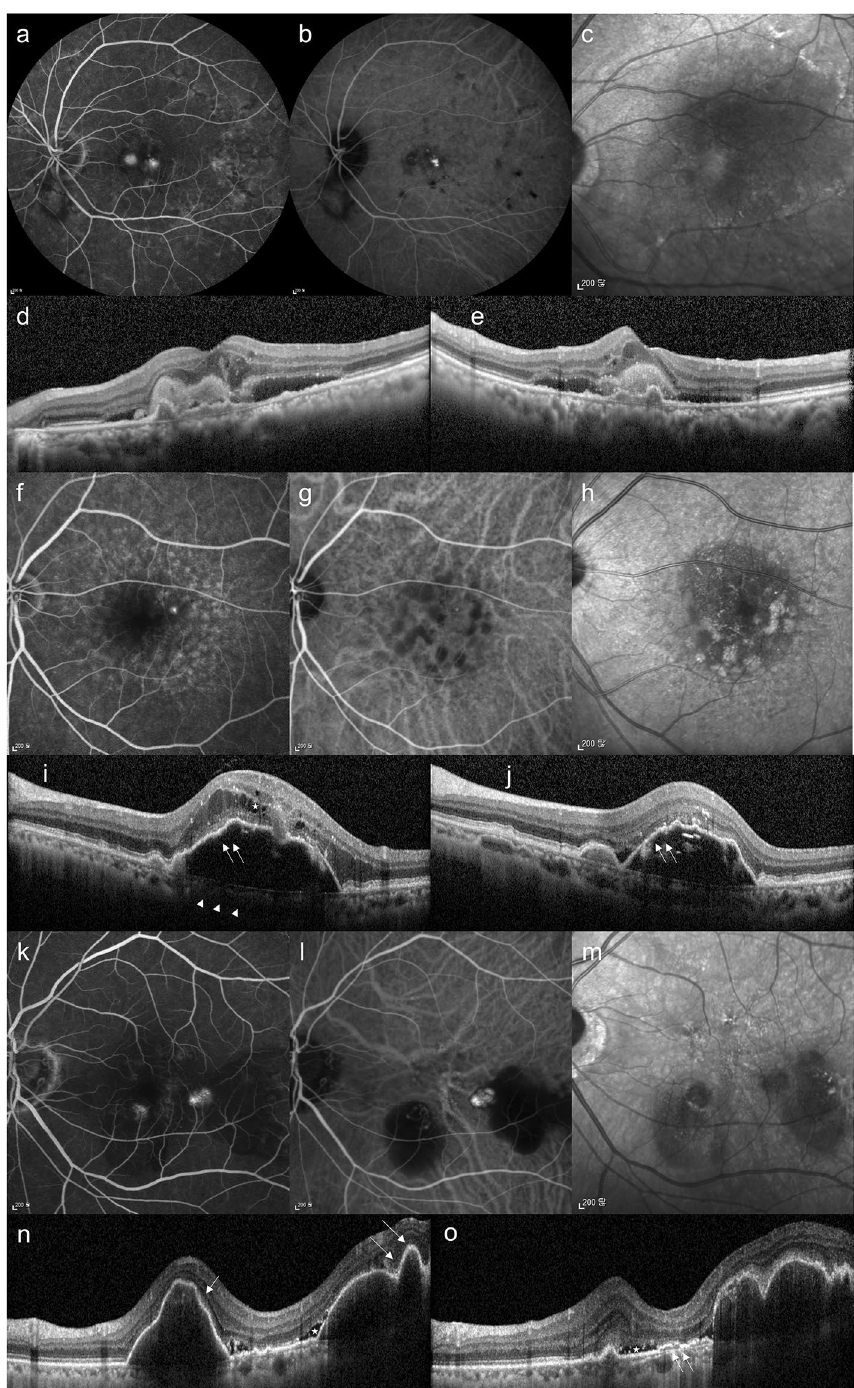
Figure 4. Representative cases of typical AMD ( a – e ), RAP ( f – j ) and PCV ( k – o ). Typical AMD. ( a ) FA, ( b ) ICGA, ( c ) IR, and ( d , e ) OCT images. The OCT images ( d , e ) show typical features of AMD with type 2 CNV. RAP. ( f ) FA, ( g ) ICGA, ( h ) IR, and ( i , j ) OCT images of an eye with RAP. The OCT images ( i , j ) show typical features of RAP: a thin choroid (arrowheads), intraretinal cyst like fluid accumulation (asterisks), and trapezoid- shaped RPED (double arrows). PCV. ( k ) FA, ( l ) ICGA, ( m ) IR, and ( n , o ) OCT images of an eye with PCV. The OCT images ( n , o ) show irregular RPE elevation with double-layer sign (double arrow), subretinal fluid (asterisks), and sharp-peaked or steeper dome-shaped RPEDs or notches (arrows). FA fluorescein angiography, ICGA indocyanine green angiography, IR infrared reflectance, OCT optical coherence tomography, CNV choroidal neovascularization, PCV polypoidal choroidal vasculopathy, RAP retinal angiomatous proliferation, RPE retinal pigment epithelium, RPED retinal pigment epithelial